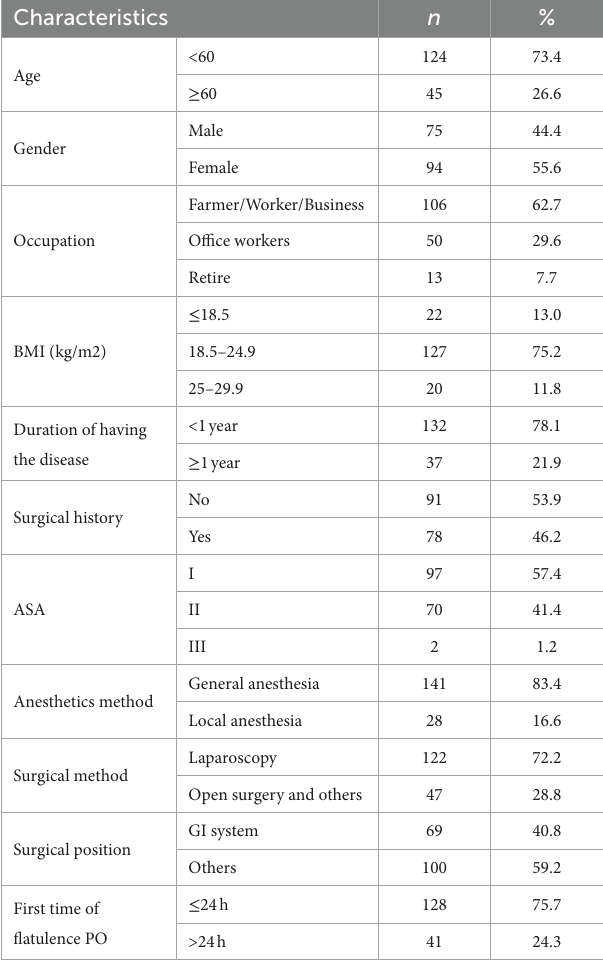
TABLE 1 Individual characteristics of participants.